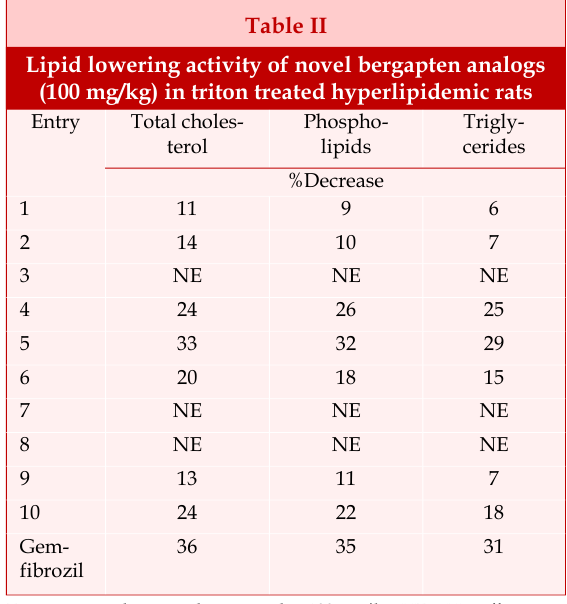
Lipid lowering activity of novel bergapten analogs (100 mg/kg) in triton treated hyperlipidemic rats Phospho-